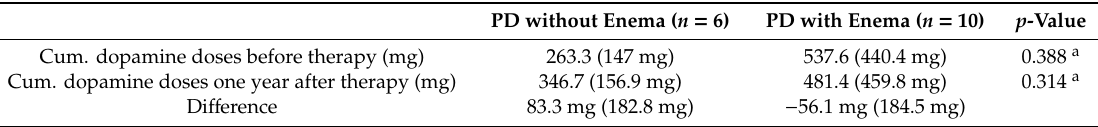
Table 4. Levodopa-equivalent daily dose before and 1 years after therapy including dietary intervention with or without enema (The given data are complete for all